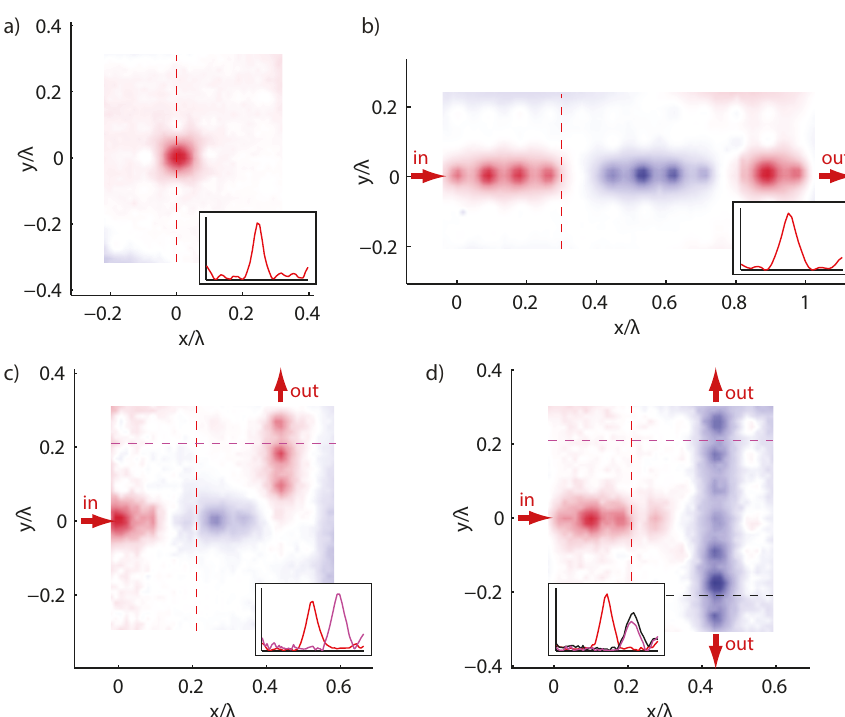
Figure 7. Molding the flow of acoustic waves at the deep subwavelength scale. Spatial distributions of the acoustic near field of the sample in amplitude when the speaker emits sounds and ( a ) the can positioned at (0,0) is filled with 6 cL of water, resulting in a ( λ /15) 2 area cavity at 465 Hz; ( b ) a line of partly filled Helmholtz resonators at y = 0 constitutes a λ /14 wide waveguide for acoustic waves at 447 Hz; ( c ) a 90 ◦ curved similar waveguide permits to bend with unity efficiency acoustic waves on a λ /14 distance at 451 Hz and ( d ) a T-shaped waveguide splits acoustic waves into two identical arms with almost equal amplitudes at 450 Hz. The insets show the profiles of the magnitude of the fields along dashed colored